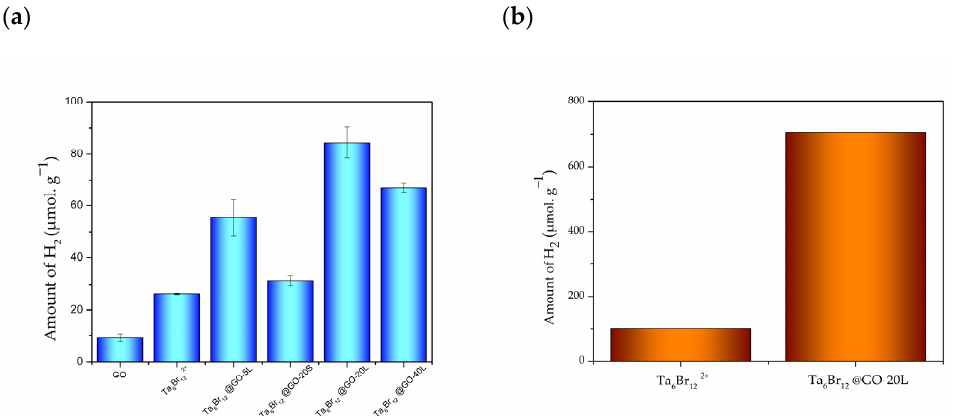
Figure 6. Amount of H 2 evolved during the photocatalytic tests with respect to: ( a ) GO, microcrys- talline molecular tantalum compound and nanohybrids catalysts; ( b ) tantalum content of the [{Ta 6 Br i12 }Br a2 (H 2 O) a4 ] and {Ta 6 Br i12 }@GO-20L catalysts.